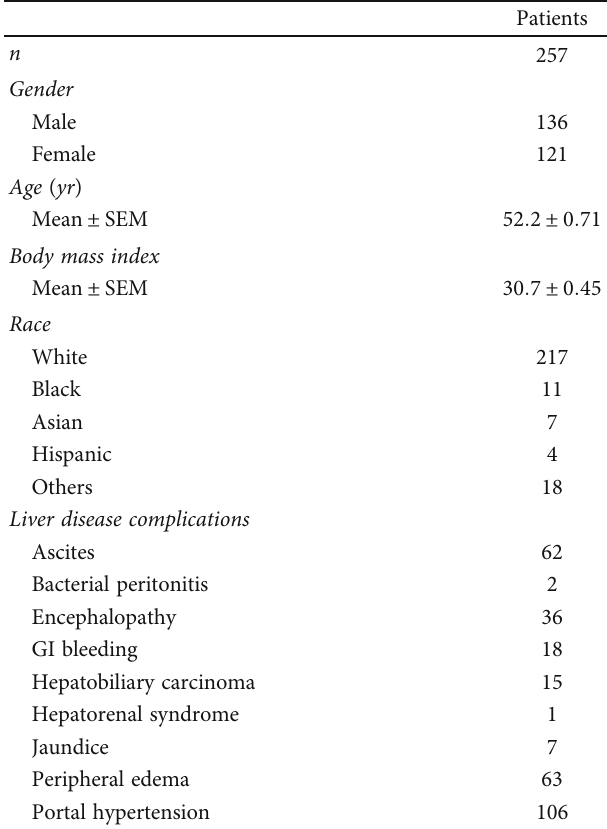
Table 2: Demographics.